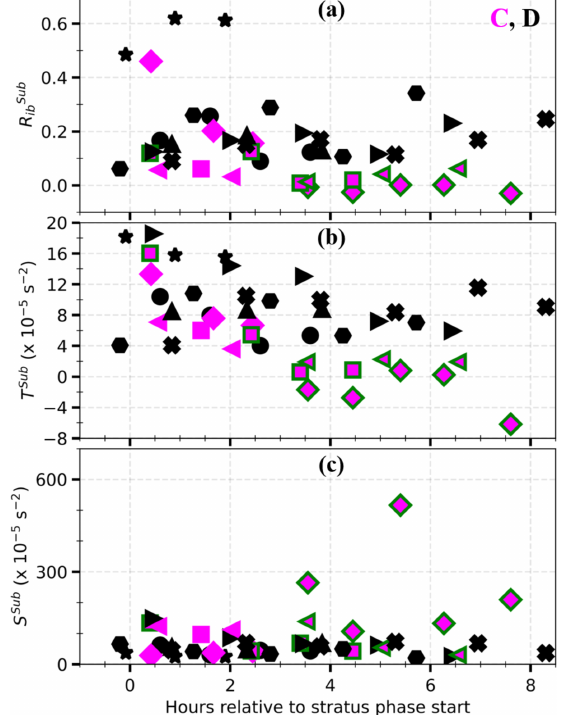
Figure 5. Evolution of the bulk Richardson number ( R Sub ; a ) and ib its thermal ( T Sub ; b ) and vertical wind shear ( S Sub ; c ) composing terms during the stratus phase based on all the soundings available until 06:00UTC on day- D + 1 during the nine selected IOPs (Ta- ble A1). The quantities are presented against the radiosonde release time, which is expressed in hours relative to the start of the stratus phase. Each IOP is represented by a marker. C and D stand for cou- pled and decoupled LLSCs at the end of the stratus phase, respec- tively. The green edge for C cases indicates that the mean distance between LLSC base height and surface-based lifting condensation level (LCL) ( (cid:49) CBH ) is less than 75m at the sounding time, meaning LCL that LLSC is coupled with the